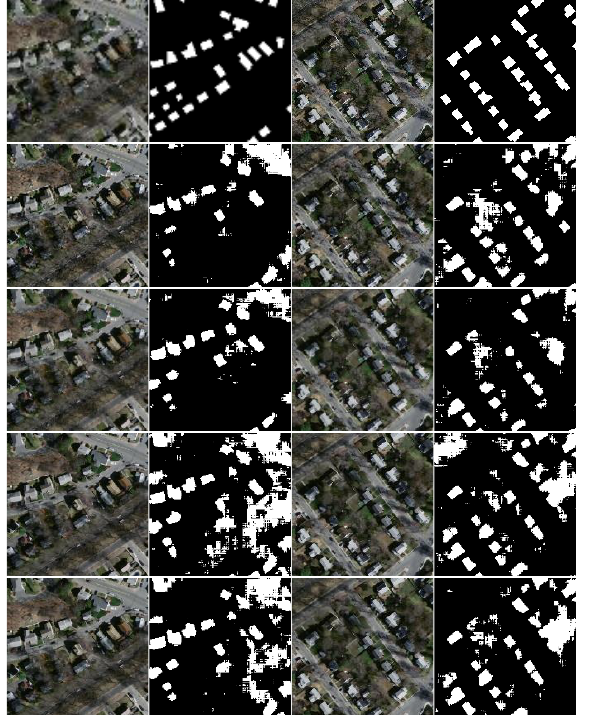
Fig. 2. Examples of the extraction results using “BI-HRNet v2”